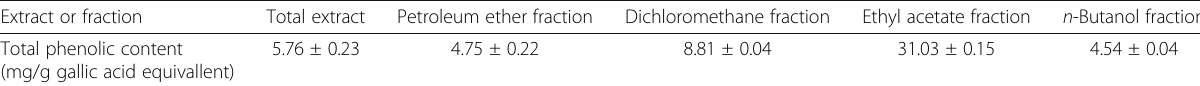
Table 1 Results representing the total phenolic content of the total ethanol extract and the different fractions of C. myxa L. leaves using Folin – Ciocalteu method Extract or fraction